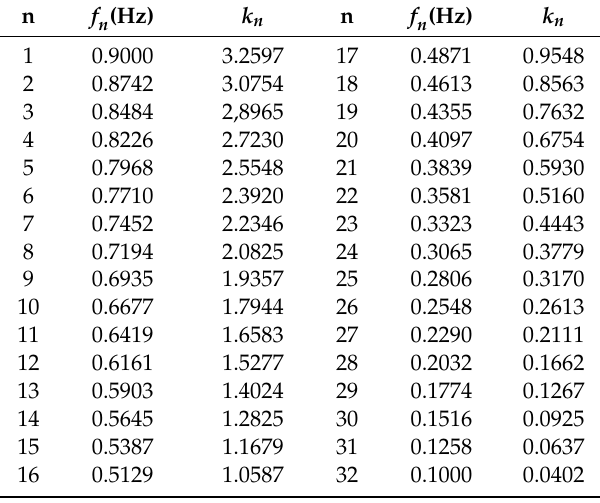
Table A1. The frequency, wavenumber, and group velocity of each wave component. The amplitude of each wave component is a n = 0.0078